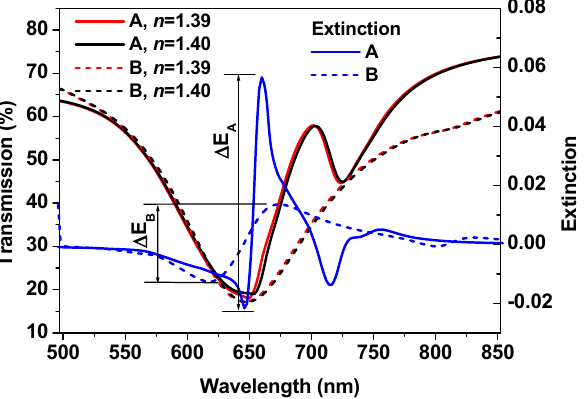
Figure 6. Simulation results showing the definition of the sensor signal and principles for the enhancement of the sensor signal through the coupling between the waveguide resonance mode and PPR in WMPCs.